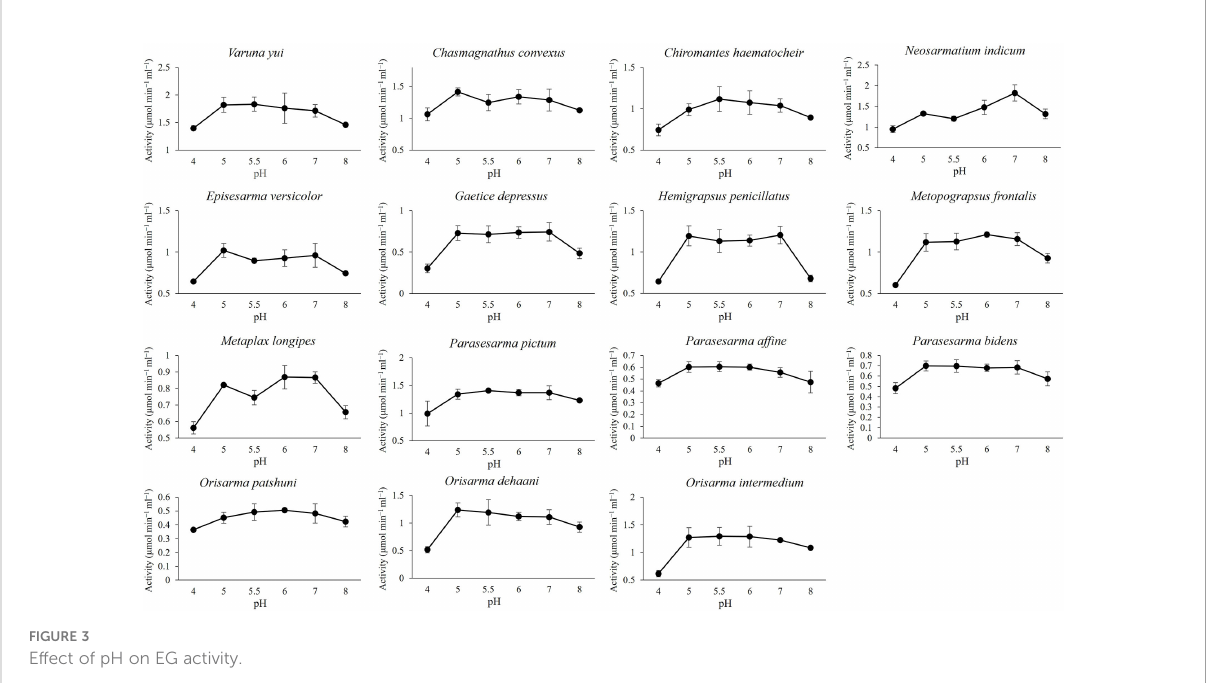
FIGURE 3 Effect of pH on EG activity.